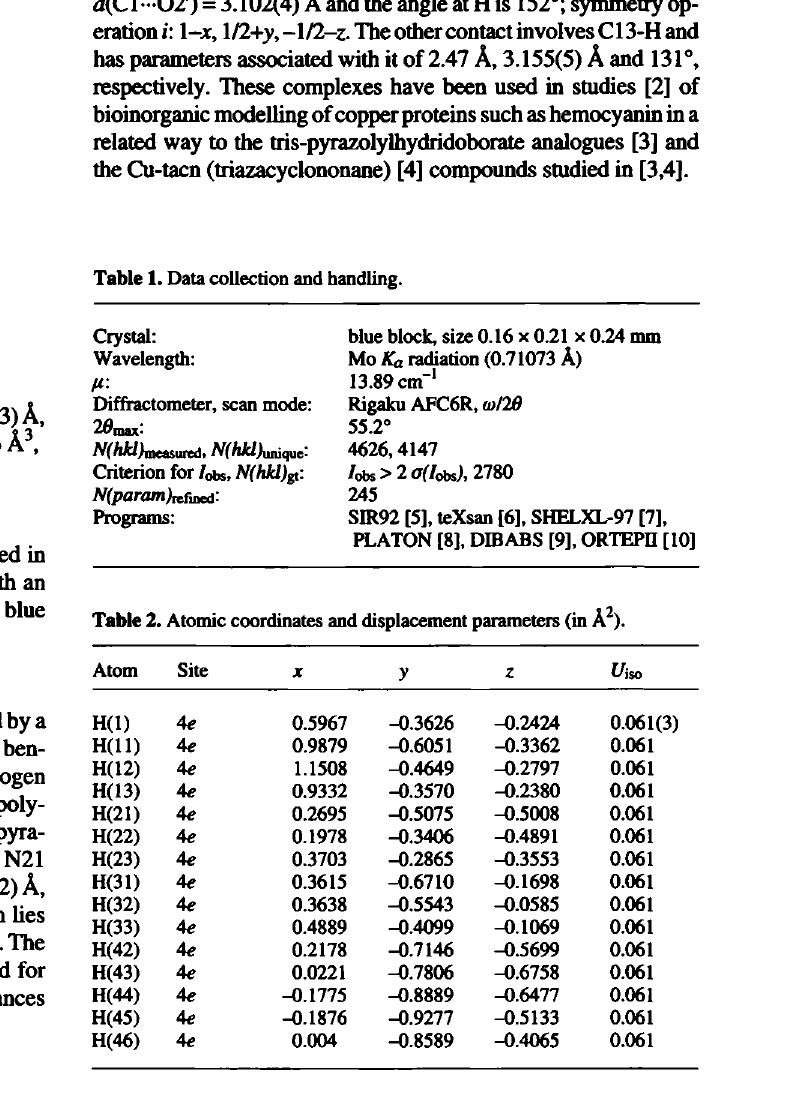
Table 1. Data collection and handling.